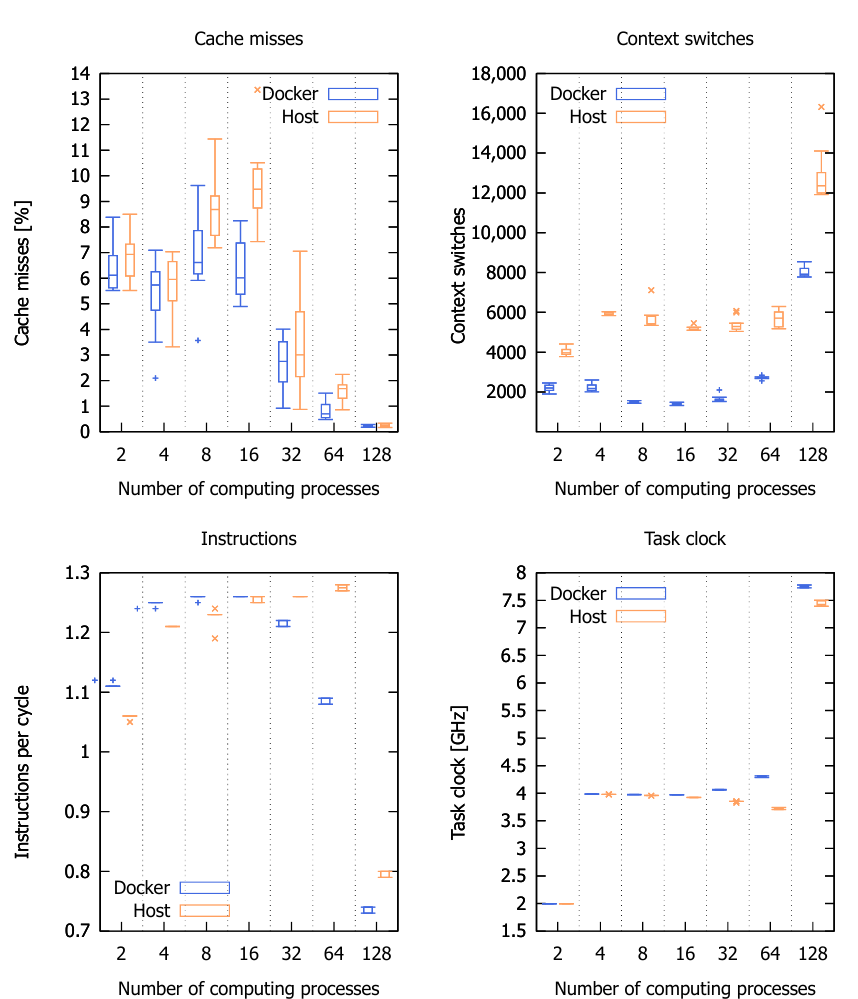
Figure 16. Hardware counters for MasterSlave program with -O3 and -march=native compilation parameters (slave node); boxplot notation: medians, Q1 and Q3, max(Q1 − 1.5IQR, minimum) and min(Q3+1.5IQR, maximum) as well as potential outliers (+ for Docker, x for Host). Communication latency between all nodes (peer-to-peer) was tested as well. Latency measurement between each two nodes was performed 20 times (both initiated the connec- tion 10 times) with the ping command and 64 bytes (with ICMP header) of data. The results of these tests are presented in Figure 19, where the X axis shows latency in milliseconds, while the Y axis shows how many times that latency occurred in all tests (the numbers of tests for Docker and Host runtime machines were the same). Docker network latency is about two times greater and less stable than for Host. The minimum, maximum and median latency values are presented in Table